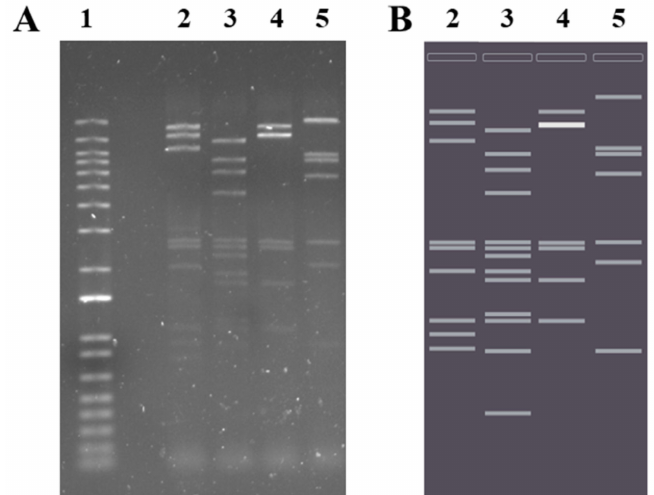
Figure 4. Analysis of restriction patterns of BB8 genome. ( A ) Electrophoretic gel image of BB8 genomic DNA digested with various restriction enzymes shows the same pattern as ( B ) in silico prepared electrophoretic gel image of the restriction fragments. Lines: (1) DNA size marker, (2) Nco I + Sma I, (3) Nco I + Nde I, (4) Nco I, and (5) Nde